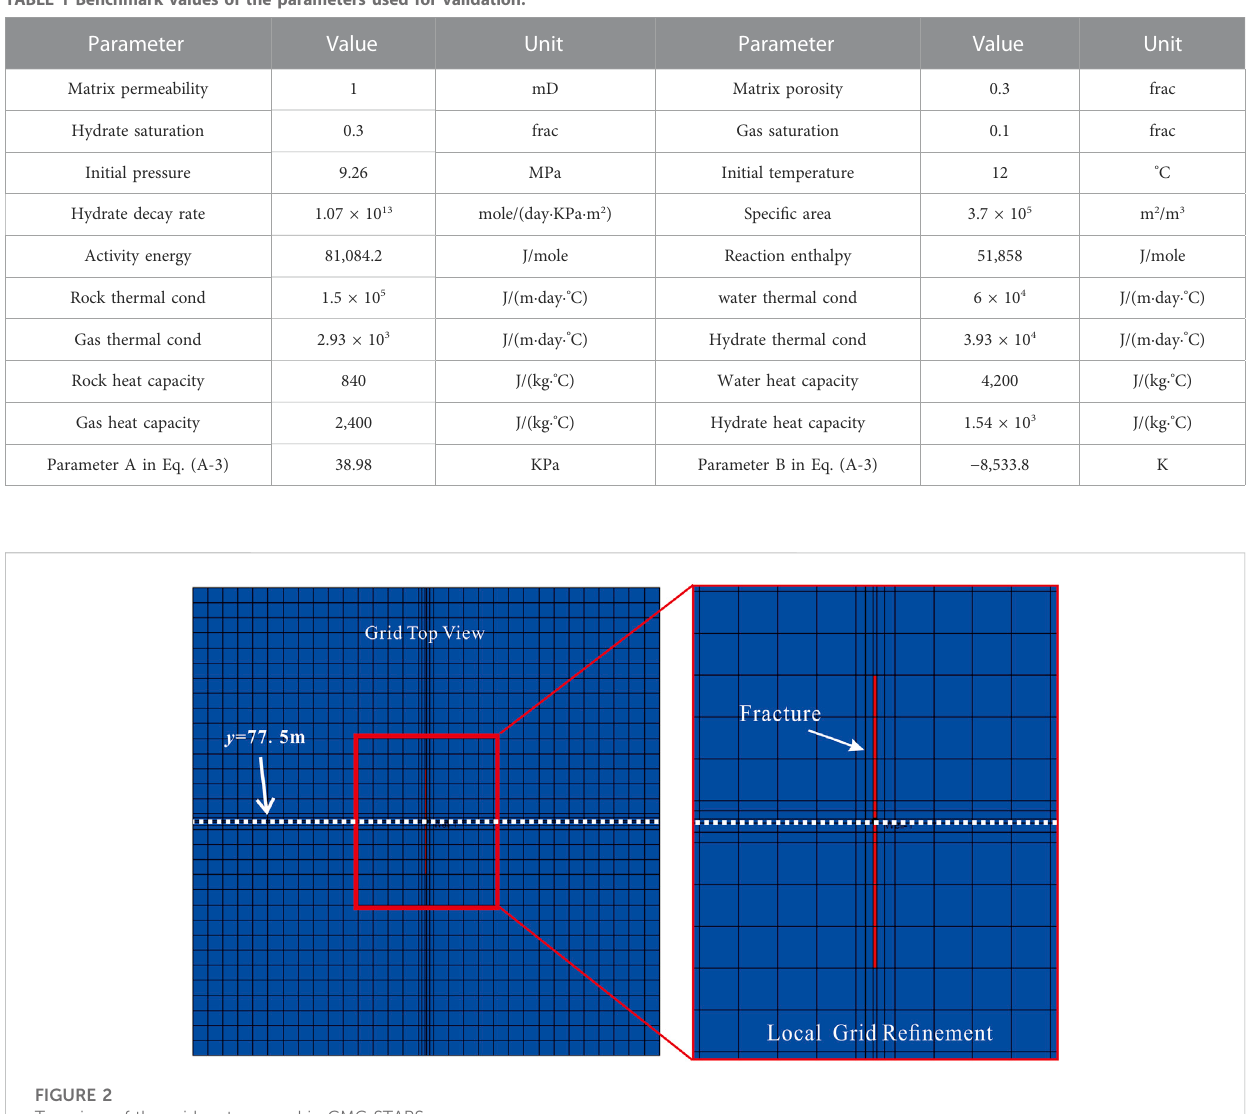
TABLE 1 Benchmark values of the parameters used for validation.